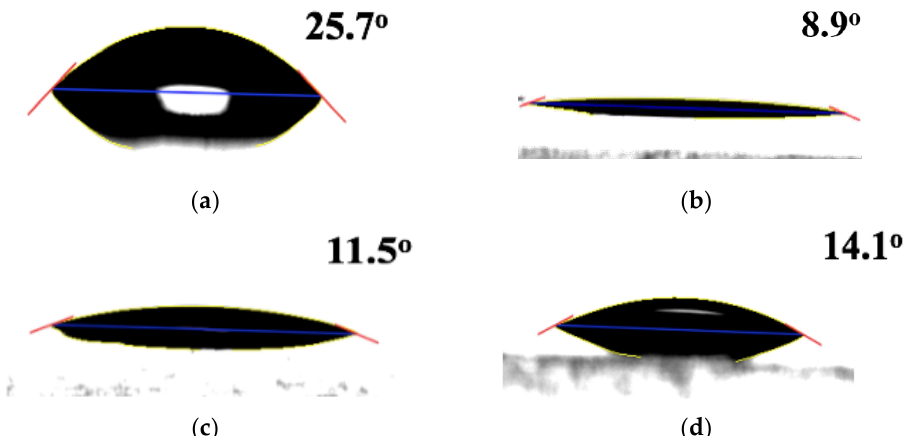
Figure 3. Contact angle characteristics according to the number of coating and annealing: ( a ) natural drying, ( b ) one step, ( c ) two steps, ( d ) three steps.